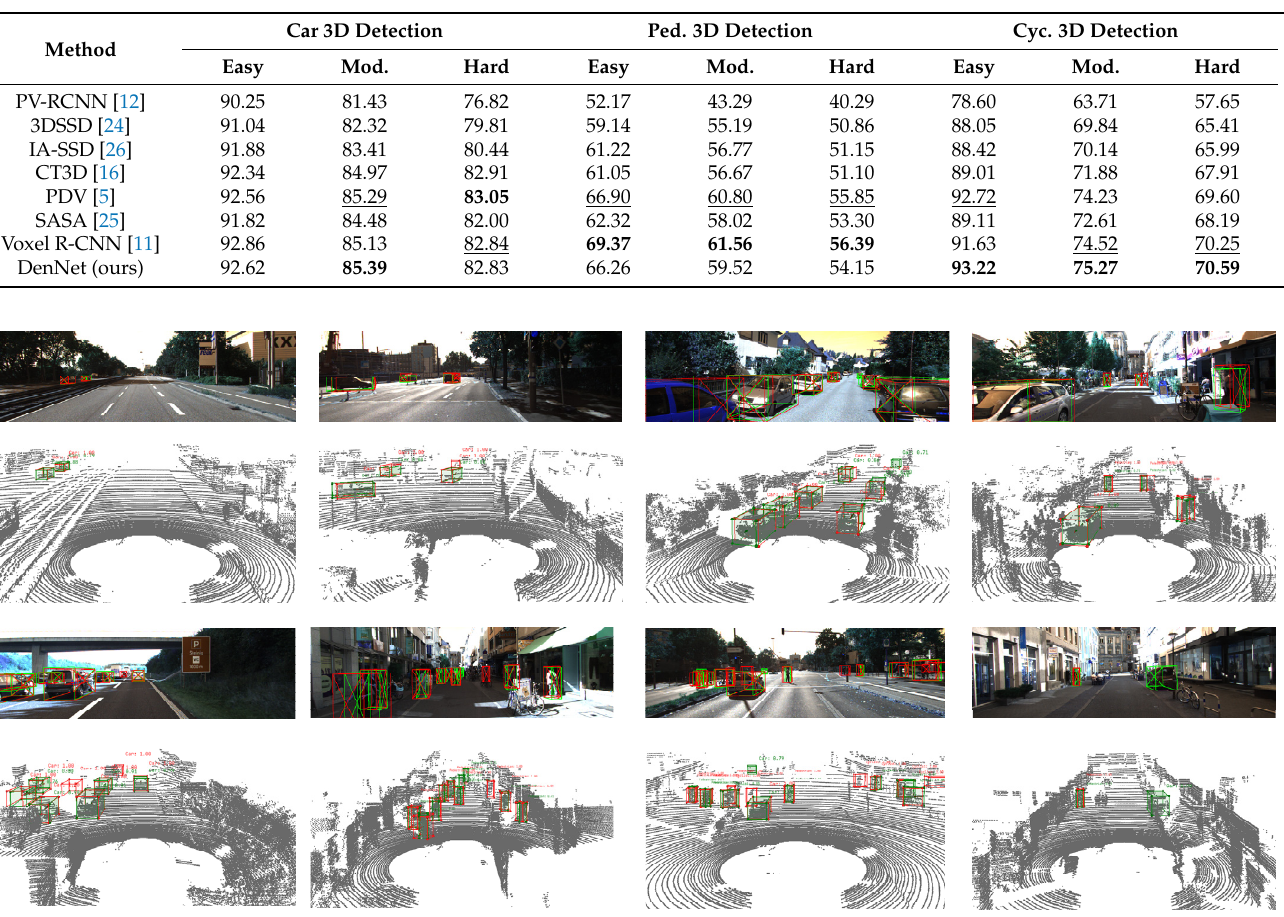
Table 2. Performance comparison on KITTI validation set. The best results are presented in bold, whereas the second-best results are underlined.